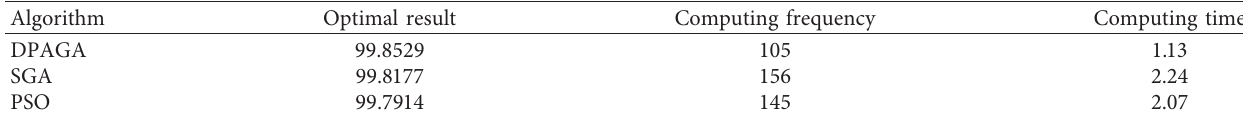
Figure 4: Comparison of DPAGA, SGA, and PSO. Table 11: Comparison of DPAGA, SGA, and